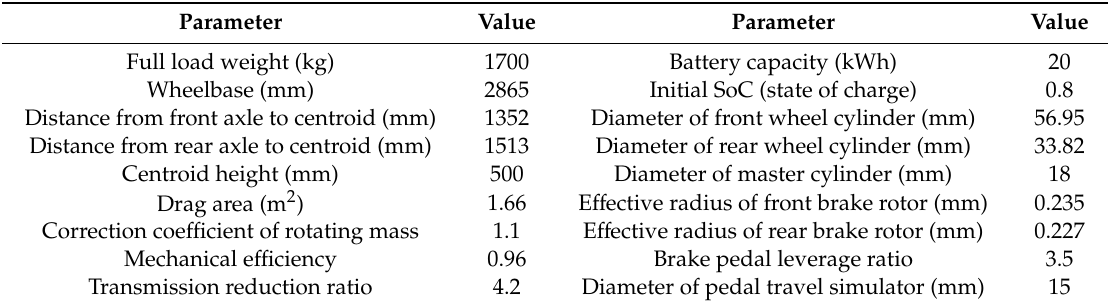
Table 1. Parameters of the multi-objective optimization (MOO) simulation model.